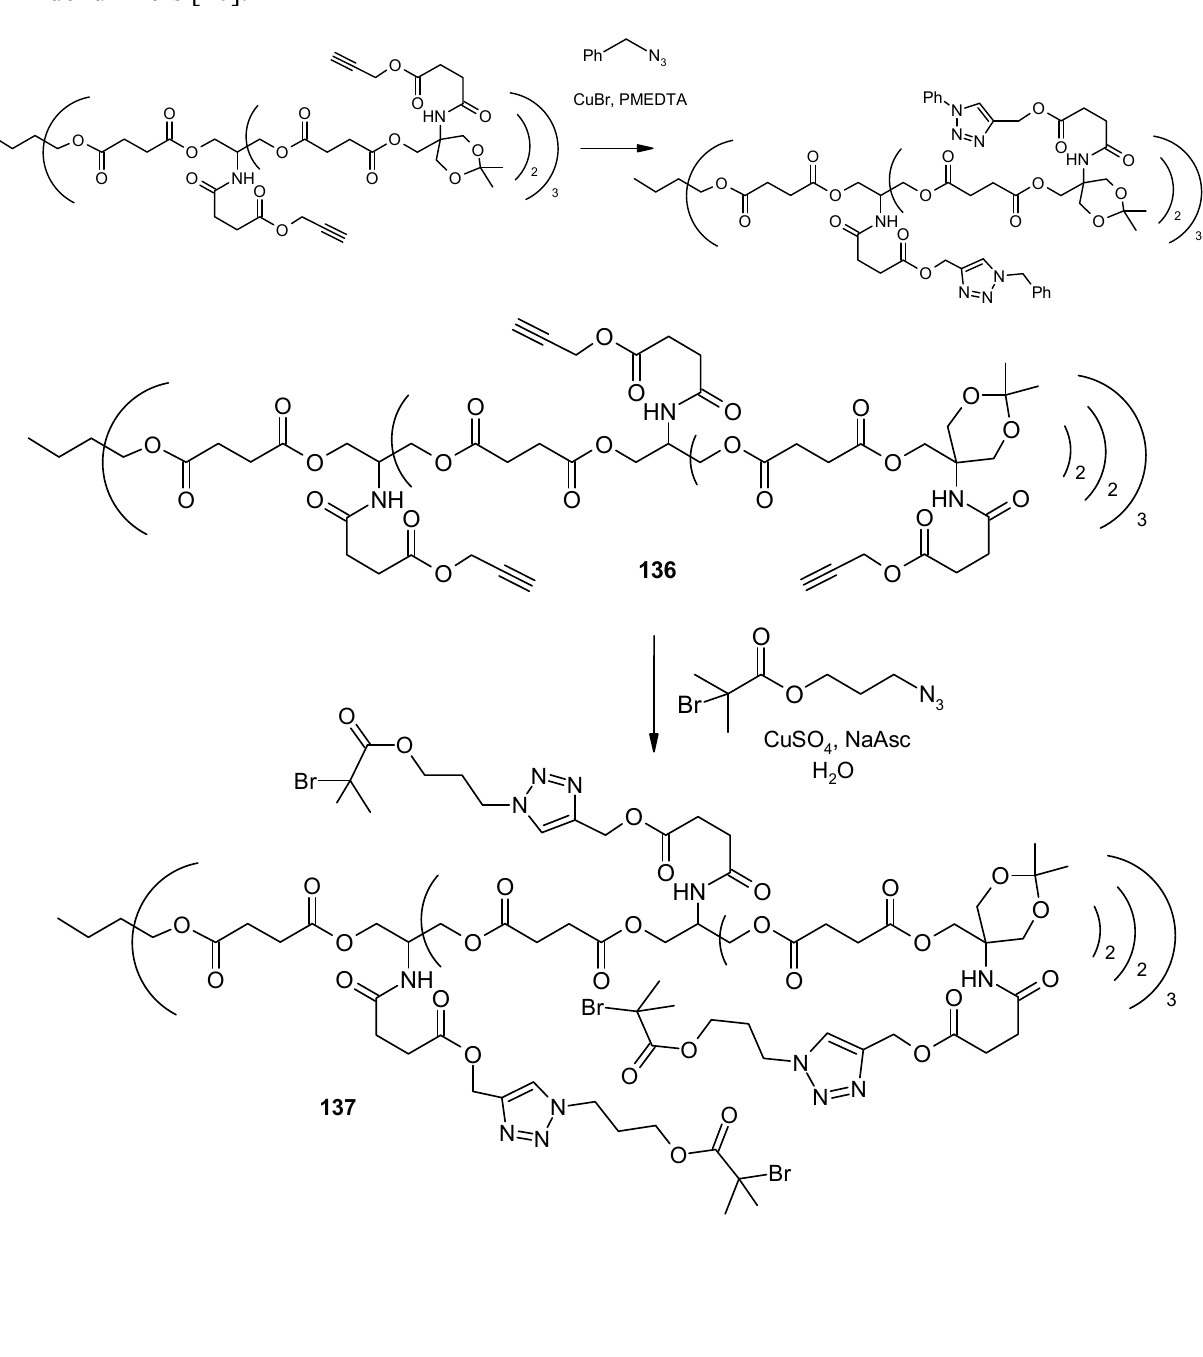
Scheme 59. Click reactions of azide-terminated molecules with the bifunctional dendrimers